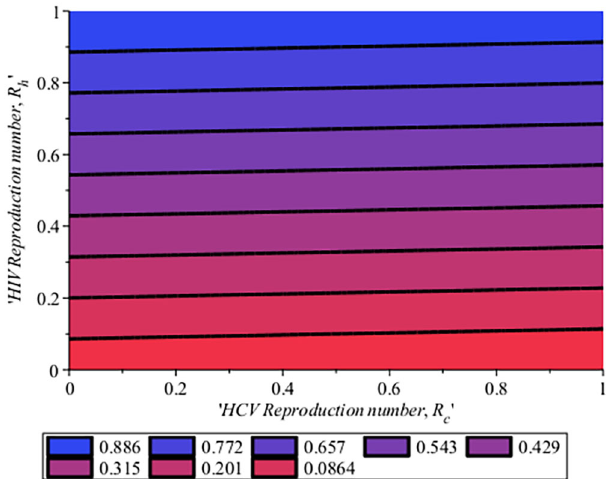
Figure 16. Impact of HCV reproduction number on HIV reproduction number.